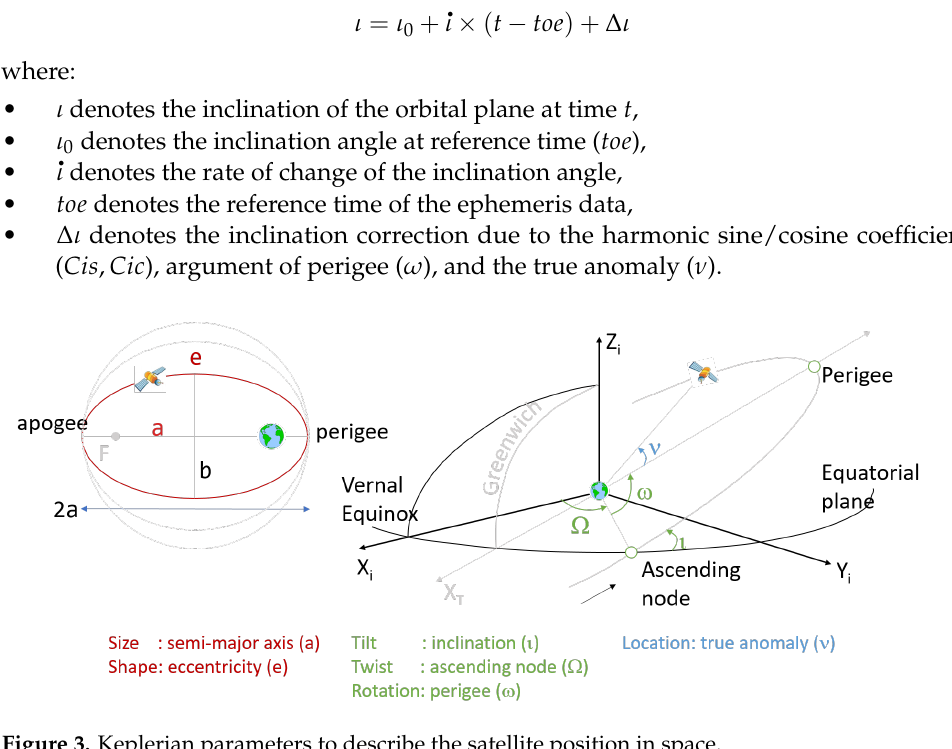
Figure 3. Keplerian parameters to describe the satellite position in